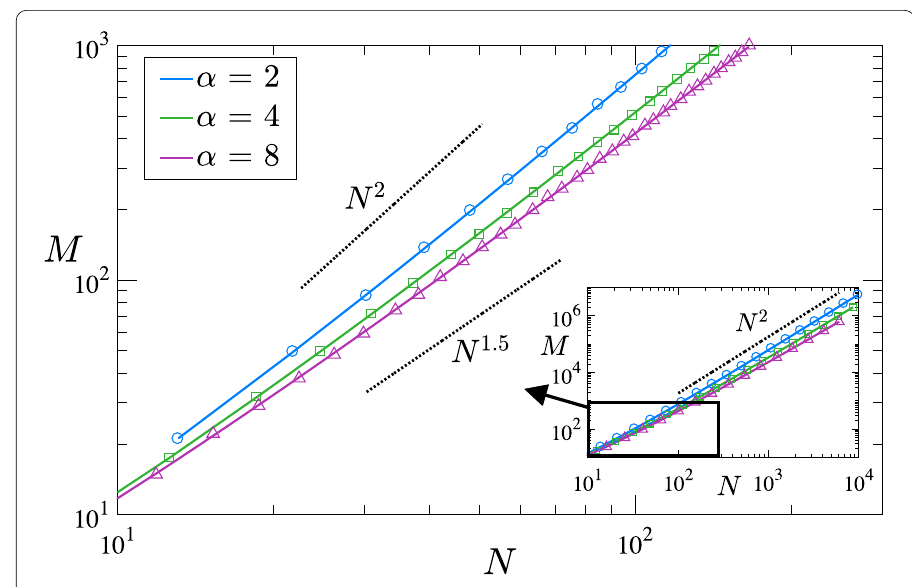
Figure 3 Superlinear relation in the fitness model. Solid lines denote the theoretical values indicated by Eq. (2), while symbols represent the corresponding simulation results (average of 500 runs). Scaling relation M ∝ N β with 1 < β < 2 emerges by varying N P when N P is small (approximately 20 ≤ N P ≤ 300). Inset : increasing N P to 10,000 restores quadratic scaling M ∝ N 2 since q 0 ≈ 0 and thereby the finite-size effect